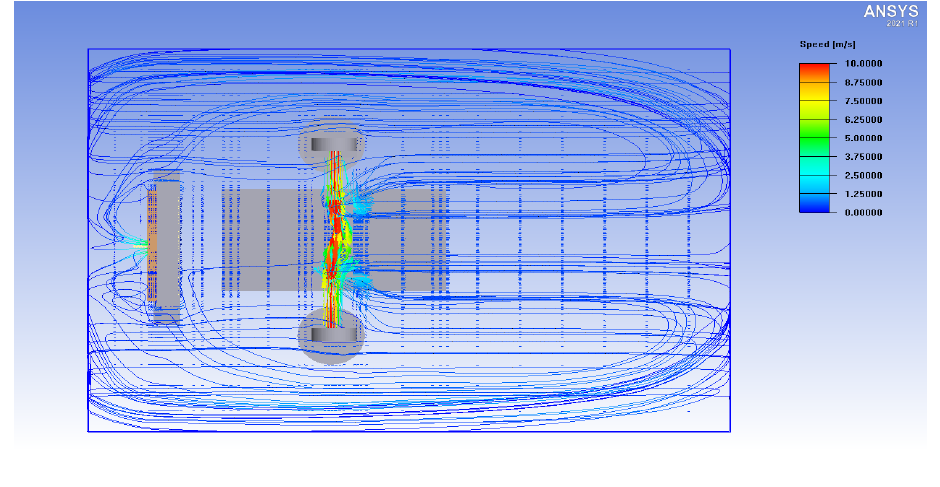
Figure 20. Air purifier top-view simulation in the consulting room at a high rotation speed − 1.